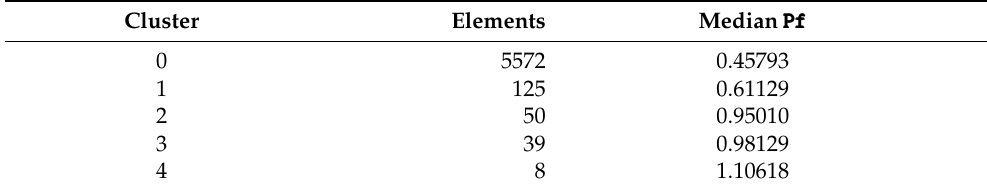
Table 4. Groups of patients according to DBSCAN .